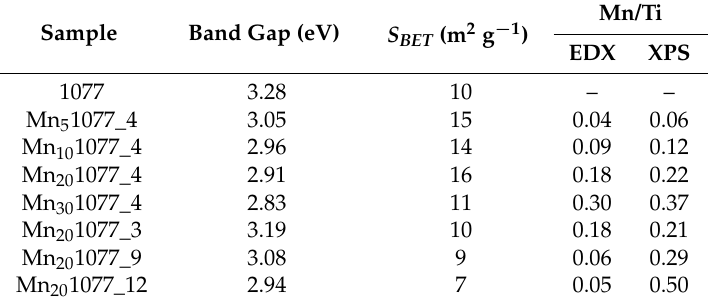
Table 2. Band gap values (by diffuse reflectance spectra (DRS)), specific surface area values (S BET ) and manganese-to-titanium (Mn/Ti) atomic ratios (by EDS and XPS) for all the adopted samples.